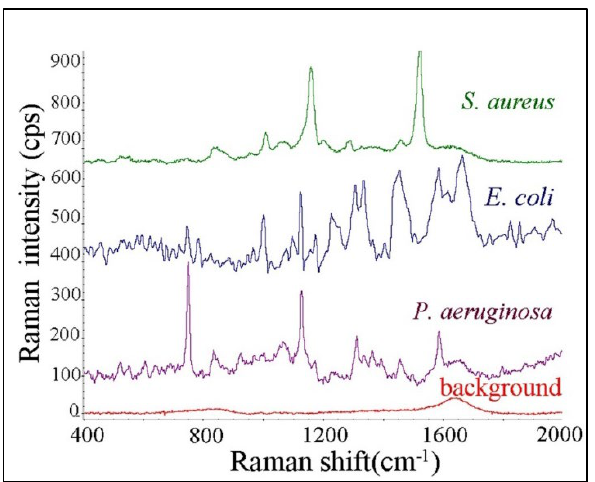
Figure 6. Averaged Raman spectra of different bacteria species. This figure is a partial reproduction from reference [100], licensed under CC BY- NC - ND 3.0 .